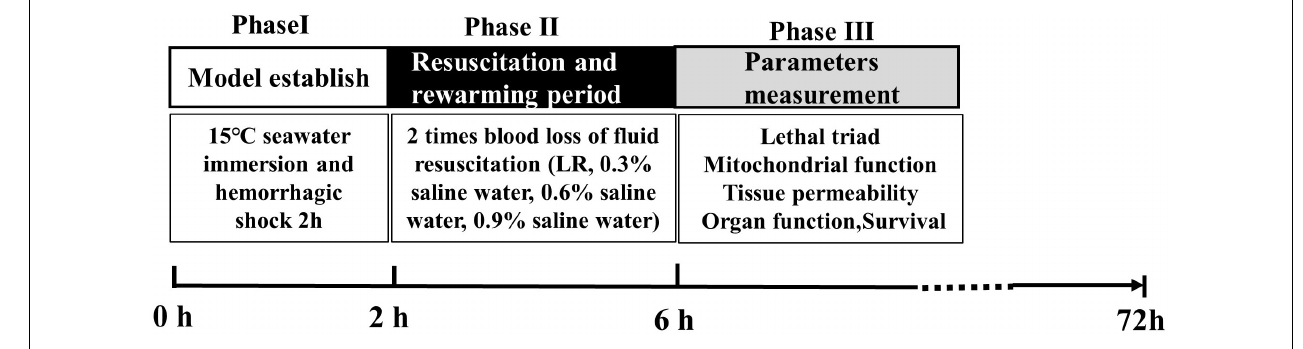
FIGURE 1 | Timeline of the experimental phases.